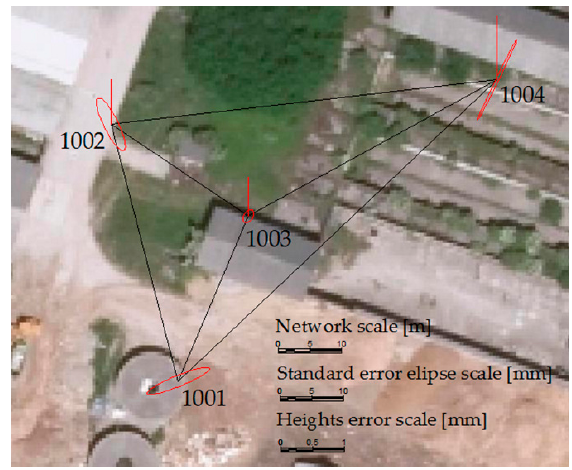
Figure 3. The accuracy of the measured height differences and standard error ellipses of the positioning coordinates of points.